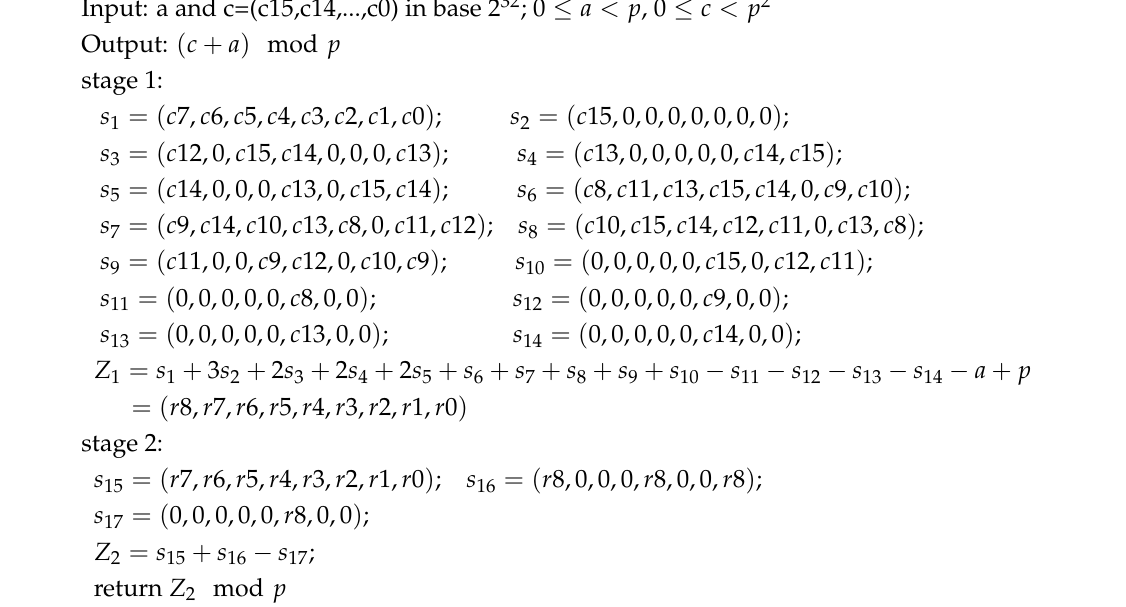
Algorithm 3: Two-stage fast reduction algorithm in